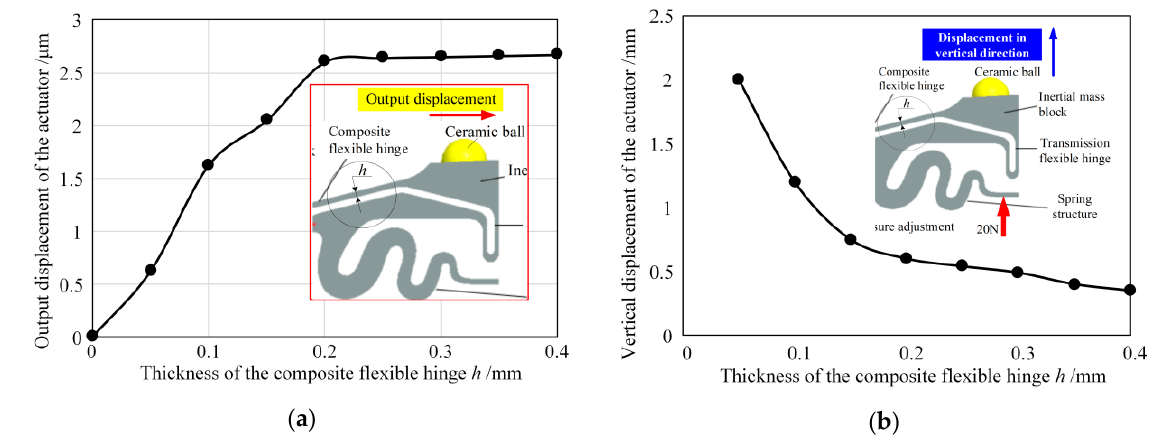
Figure 5. Influence of the composite flexible hinge thickness on ( a ) output displacement of the actuator and ( b ) vertical displacement of the inertial mass block.